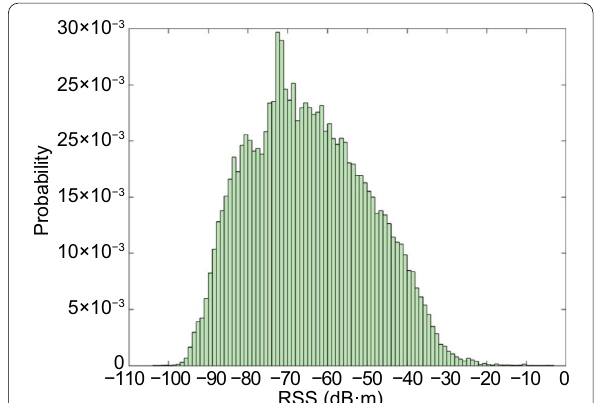
Fig. 3 The distributed probability of RSS values in three